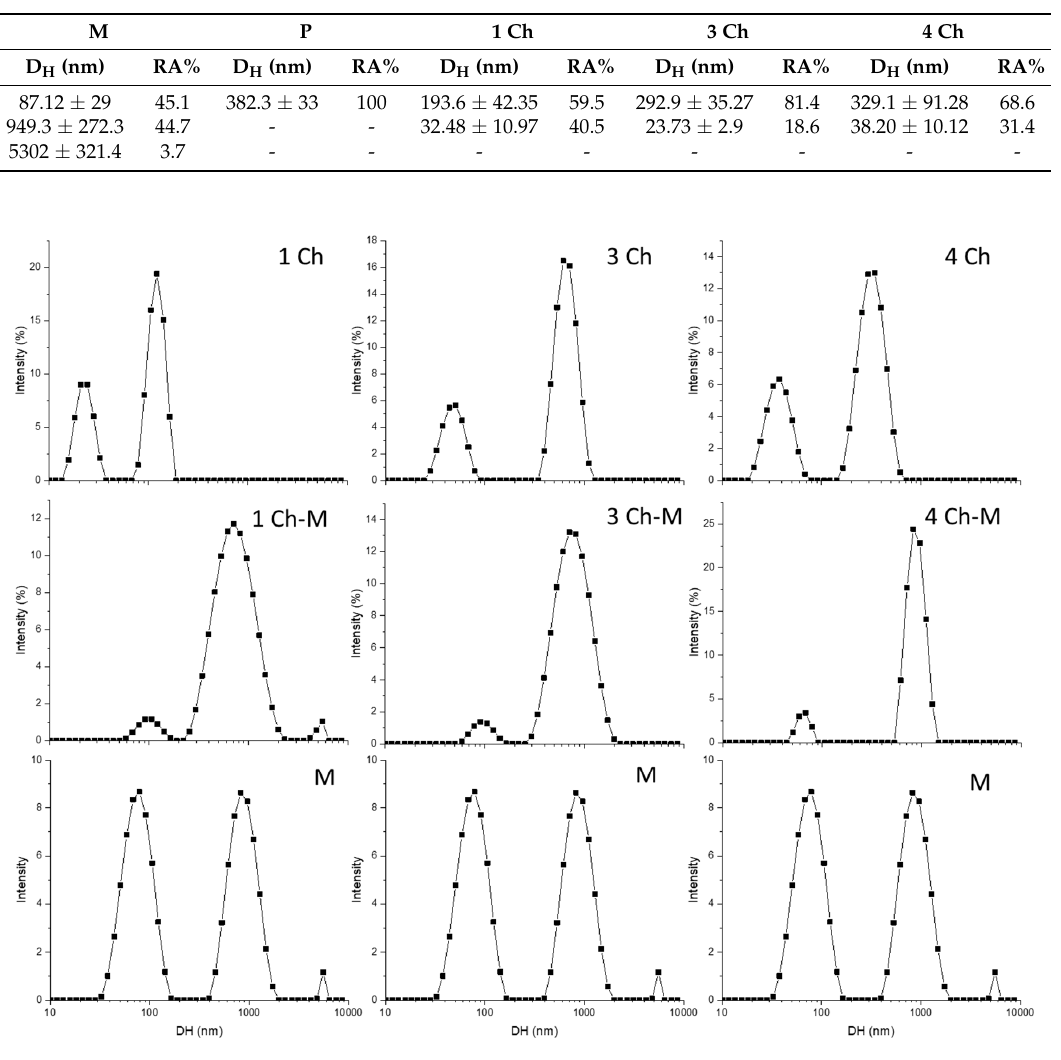
Figure 4. Intensity weighted particle size distributions of Ch, Ch–M and M solutions obtained by DLS.